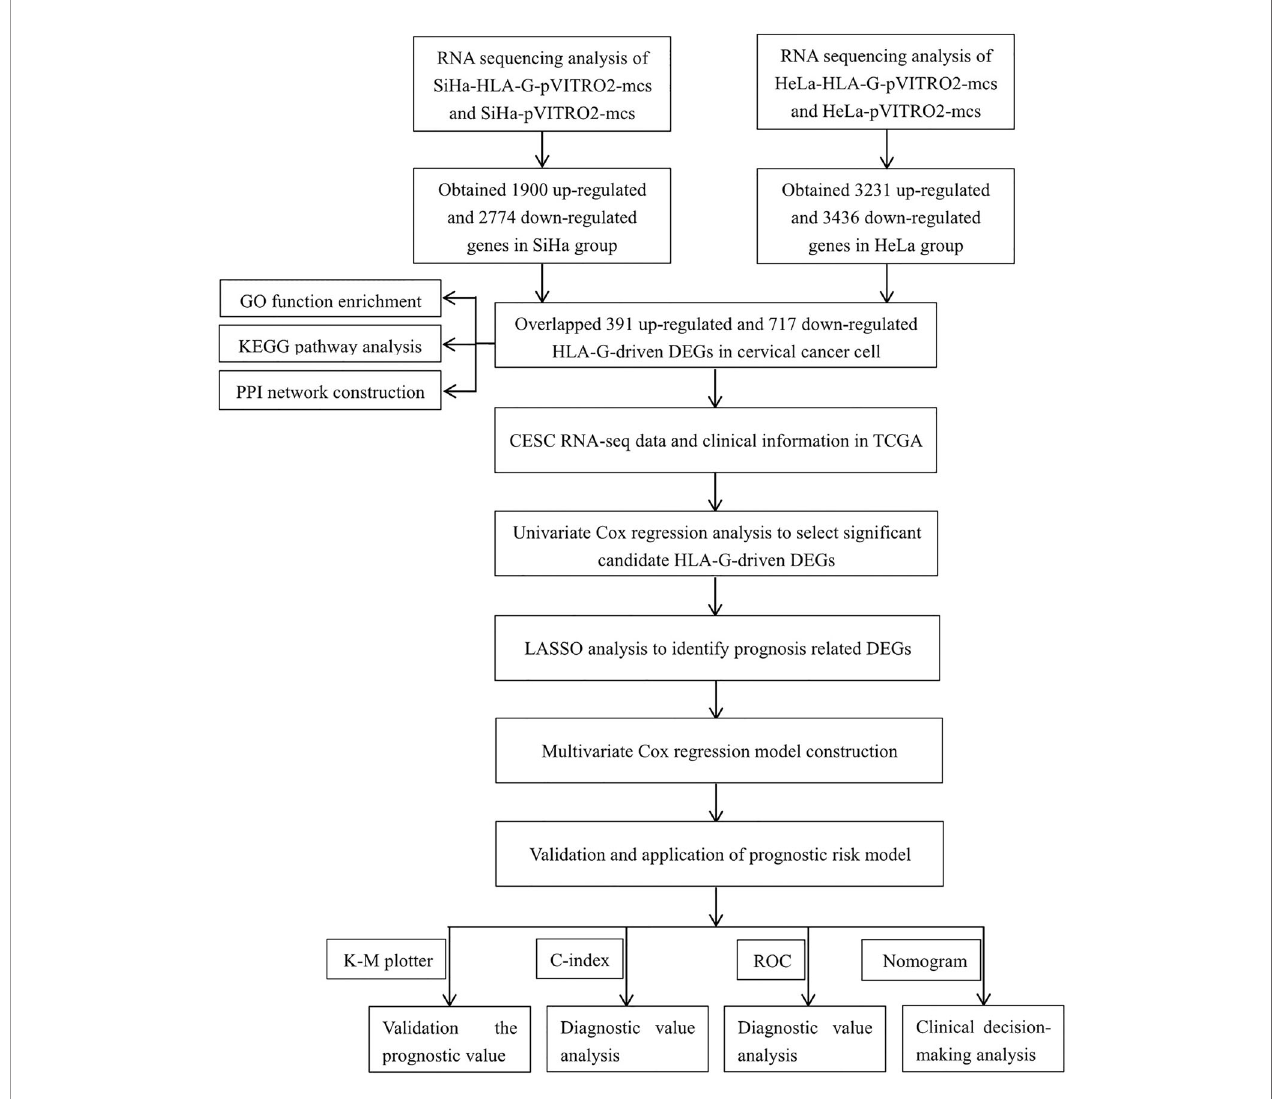
FIGURE 1 | Flow diagram of this